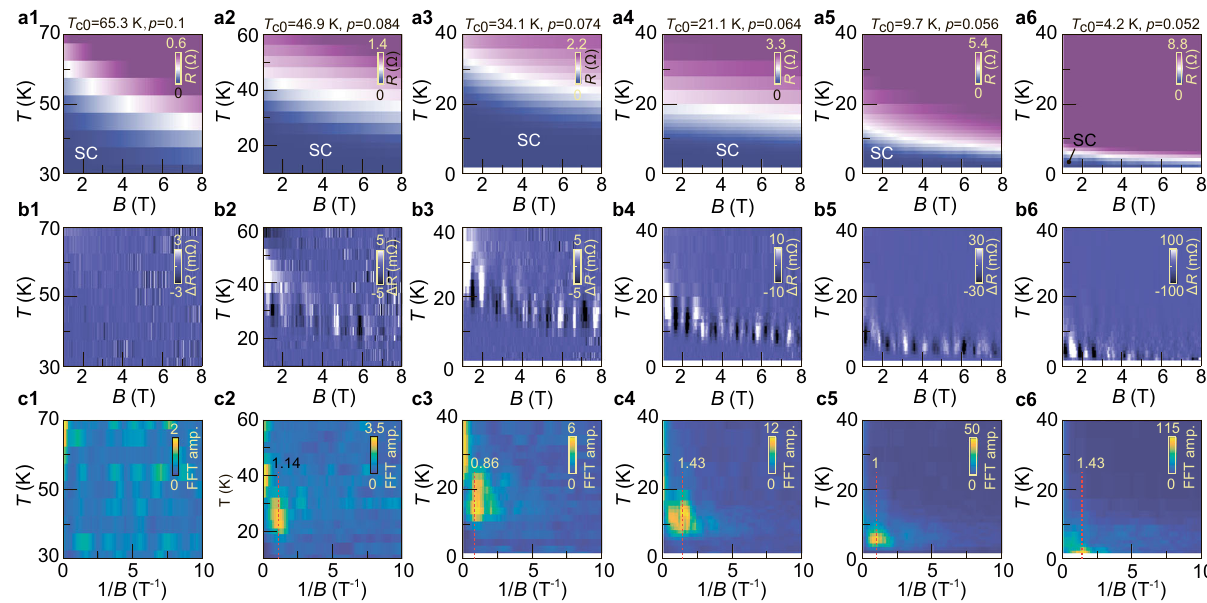
Fig. 2 Doping dependence of the magneto resistance and the oscillations. a1 – a6 Color-coded resistance of sample S3 as a function of magnetic fi eld and temperature R B ; T ð Þ . The white stripe demarcates the boundary between the superconducting (SC) region and the normal state. b1 – b6 Background subtracted resistance as a function of magnetic fi eld and temperature: Δ R B ; T ð Þ : The oscillation amplitude increases with decreasing doping. c1 – c6 FFT of Δ R B ð Þ at different temperatures. Vertical dotted lines with numbers indicate the peak positions. Each column of this fi gure corresponds to the same doping level indicated on the top.